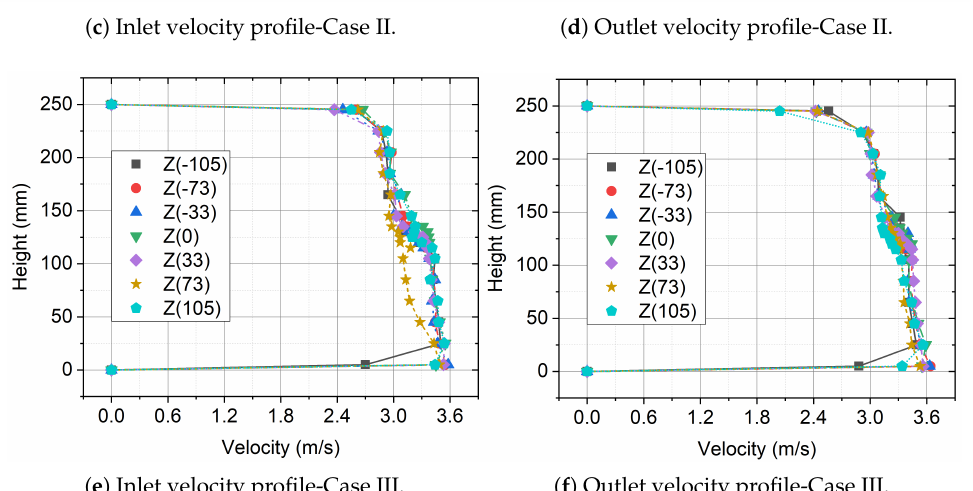
Figure 7. Velocity profiles of cross section at different